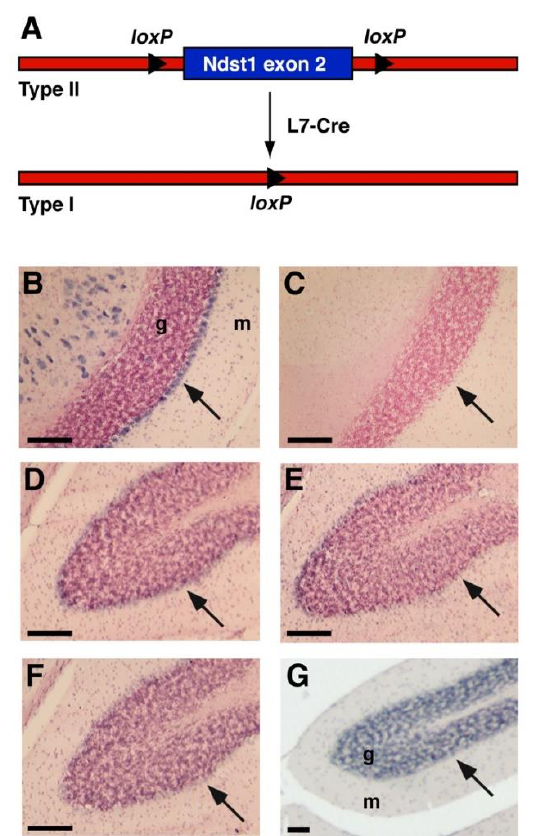
Figure 1. Disruption of the Ndst1 gene expressed in cerebellar Purkinje neurons by targeted recombination. ( A ) Maps of the Type II “floxed” Ndst1 allele and a cell-type-specific Type I deletion allele, obtained after breeding of Type II mice with L7-Cre mice. Lox-sites located in intron sequences are shown as triangles. ( B – G ) In situ hybridization of adult wildtype cerebellum showed strongest Ndst1 expression (B, blue stain) in cerebellar Purkinje cells (arrows) as well as in unidentified cell types in the white matter, possibly myelin-forming oligodendroglia. Sense controls showed no reactivity ( C ). Ndst2 ( D ), Ndst3 ( E ) and Ndst4 ( F ) expression were barely detectable in Purkinje cells. Tissue sections were probed with an antisense riboprobe specific for Ndst1-4 . ( G ) H&E staining of the corresponding cerebellar area. g: granule cell layer, m: molecular layer. Scale bars: 100 μm.